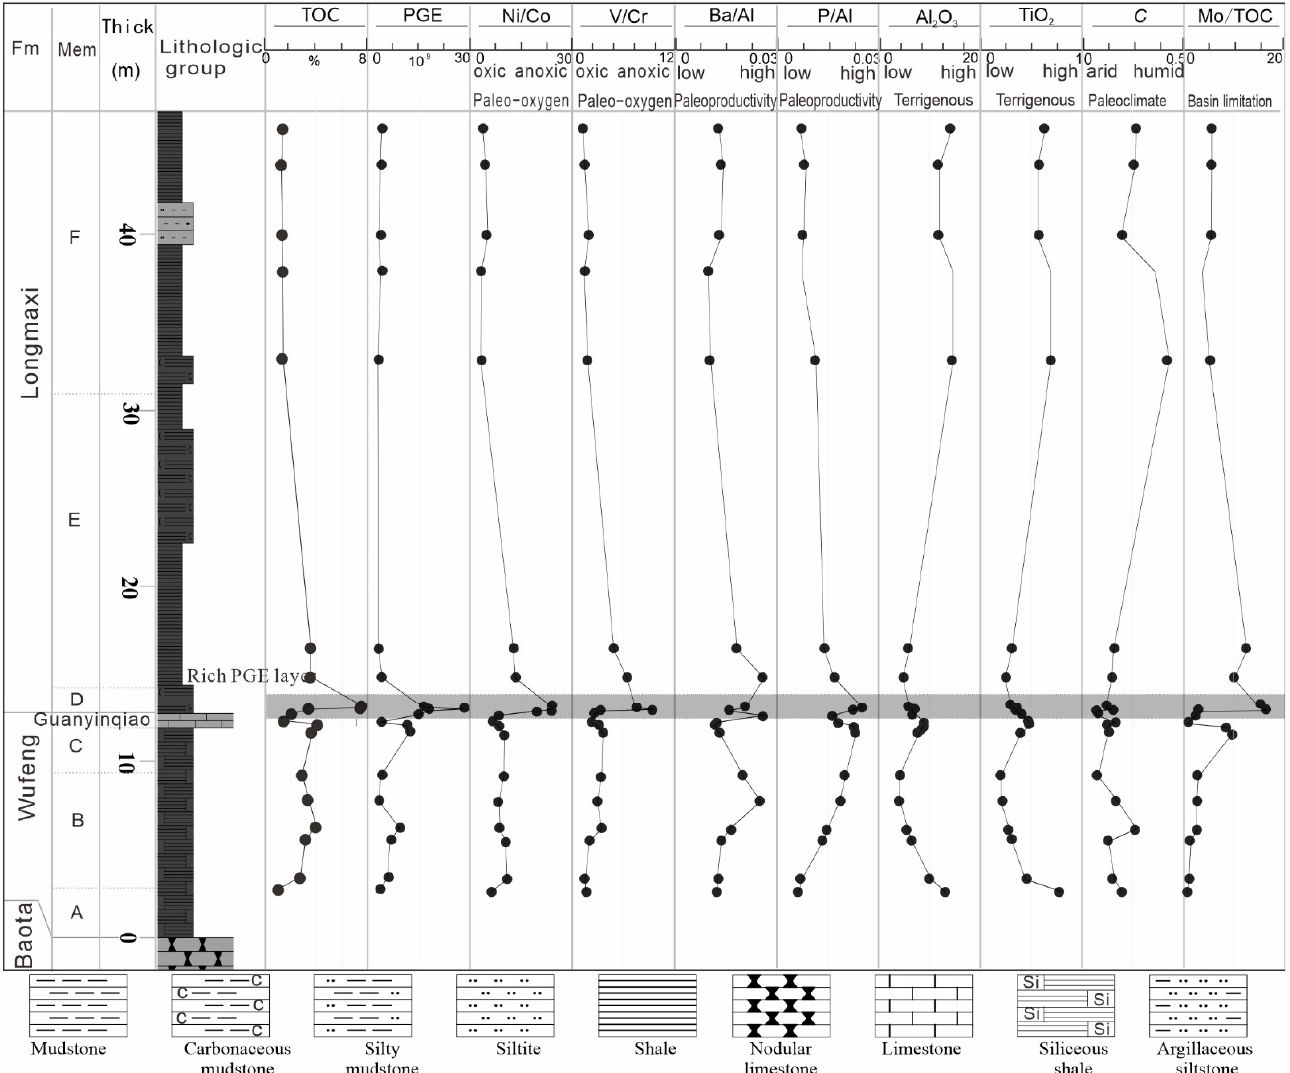
Figure 12. Stratigraphic profiles of CN outcrop for correlation between PGEs and high TOC main controlling factors.